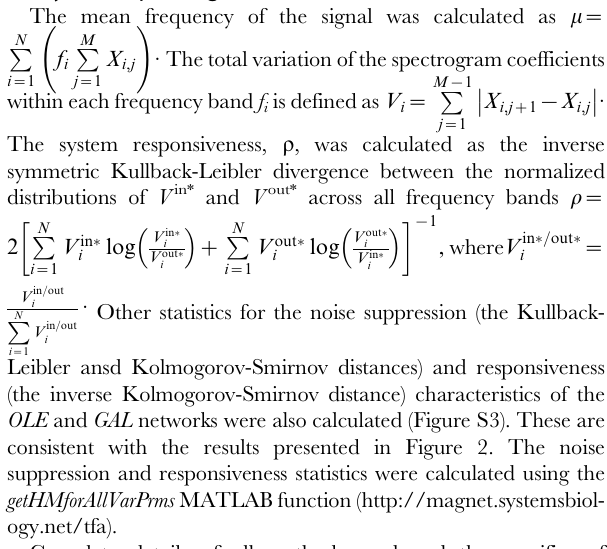
Figure S3 Responsiveness/noise suppression contour plots for (A, B, C) GAL , (D, E, F) WT- OLE , and (G, H, I) adr1 D oaf3 D - OLE networks. Contour plots were calculated based on TFA charac- teristics of 3000 random stimuli/system responses (see Figure 2 in the main text). j 1 denotes the symmetric Kullback-Leibler divergence between the distributions of the input and output spectrogram coefficient sums across all frequency bands. j 2 denotes the Kolmogorov-Smirnov distance between the distribu- tions of the input and output spectrogram coefficient sums across all frequency bands. r 1 denotes the inverse Kolmogorov-Smirnov distance between the normalized total variation distributions of the input and output spectrogram coefficients across all frequency bands. The noise suppression and responsiveness statistics were calculated using the getHMforAllVarPrms MATLAB function (http://magnet.systemsbiology.net/tfa). Figure S4 Responsiveness/noise suppression plots for (A) WT- GAL , (B) WT- OLE , (C) WT-LPS, (D) adr1 D - OLE , (E) oaf3 D - OLE ,